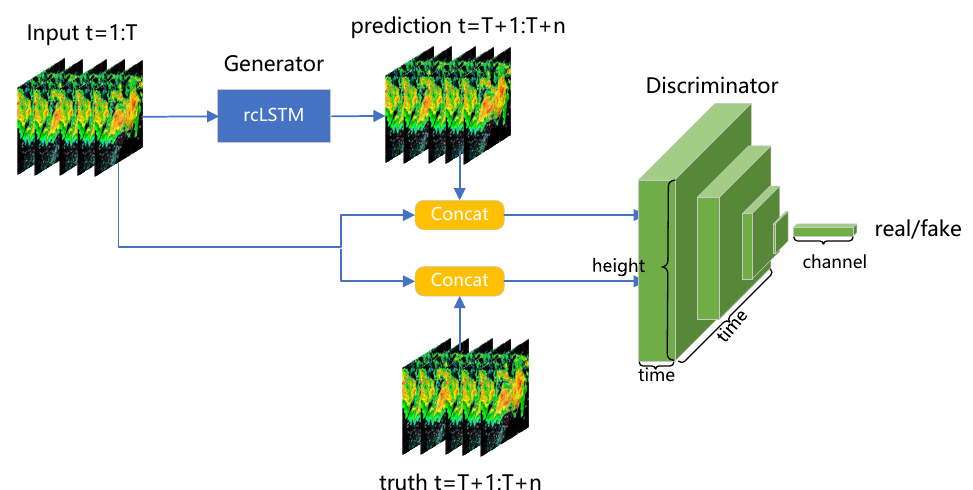
Figure 2. The structure of the GAN-rcLSTM model.